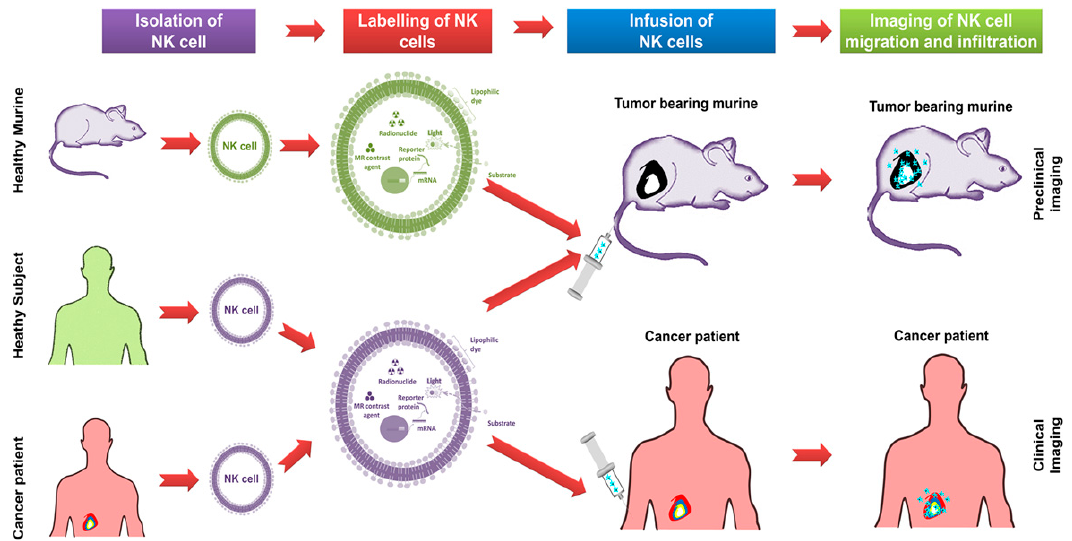
Figure 2. An overview of steps involved in tracking NK cell migration and infiltration using non- invasive in vivo imaging approaches. NK cells obtained from murine or healthy subject or cancer patients; labeling of NK cells with imaging agents; the infusion of NK cells into a tumor-bearing murine model or cancer patient and in vivo imaging of NK cell migration and infiltration by various modalities such as fluorescence and bioluminescence imaging (preclinical) as well as magnetic resonance imaging, positron-emission tomography and computerized tomography (clinical).